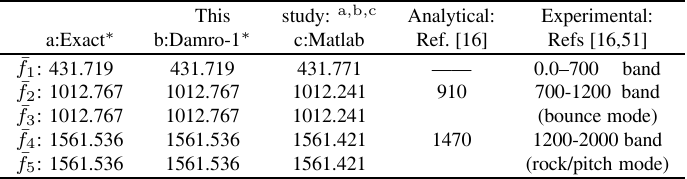
Table 8 Natural frequencies ¯ f k (Hz) of spindle-ball bearings assembly for Ω s = 0, Bearing